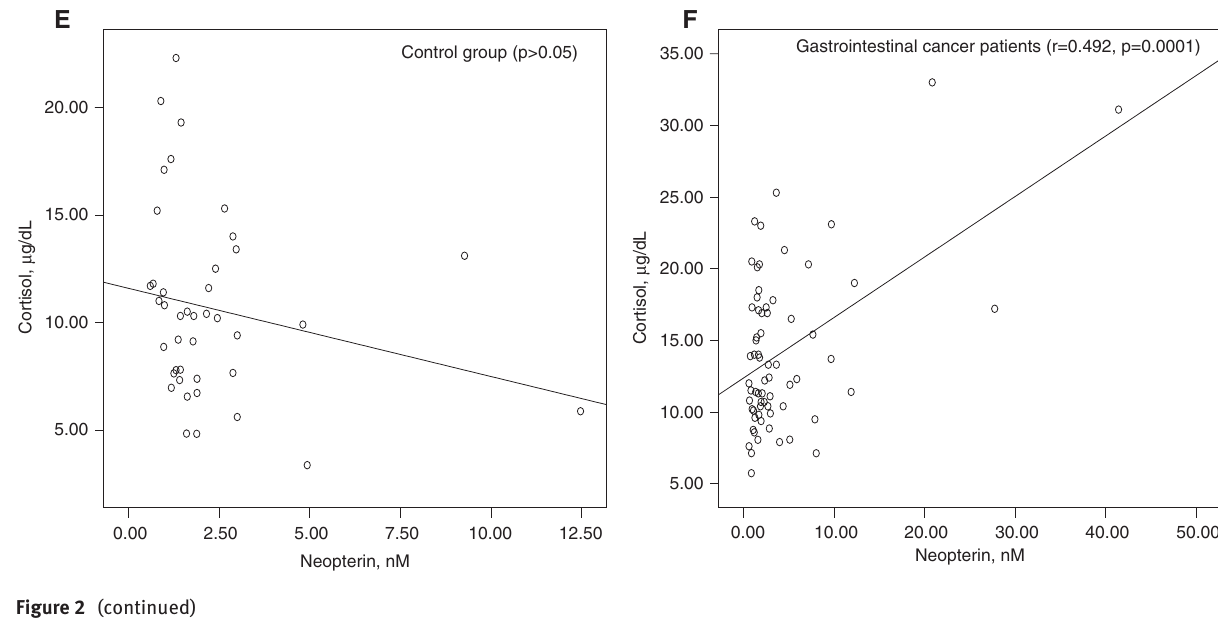
Table 4: Progressive increase in neopterin production with the advancement of the stage in gastrointestinal cancer cases. Group (n) Neopterin Median Control group (n =